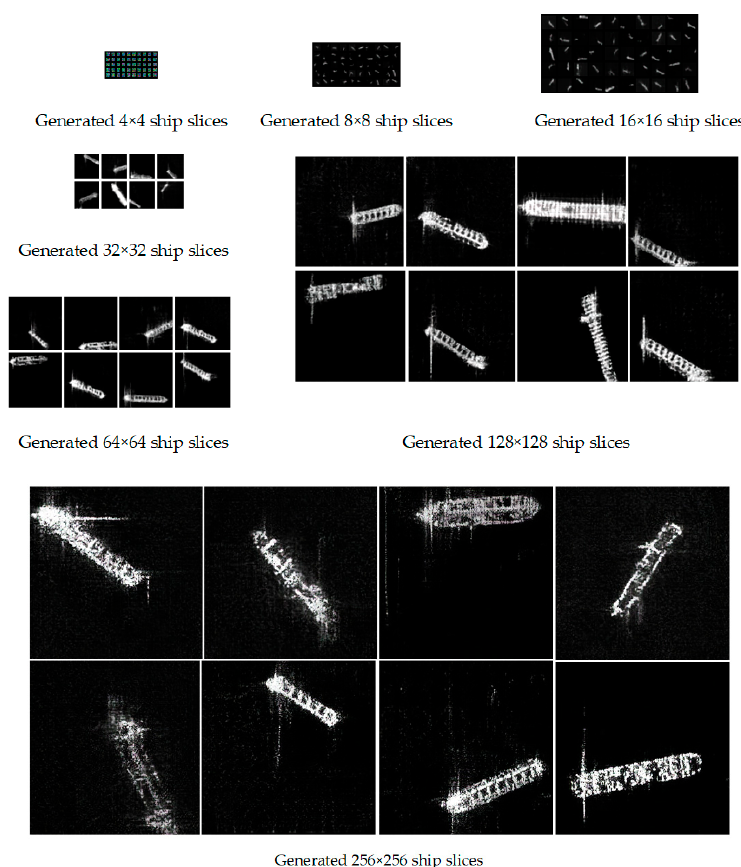
Figure 5. Different scales of SAR ship slices generated by the Multiscale Wasserstein Auxiliary Classifier Generative Adversarial Networks (MW-ACGAN).